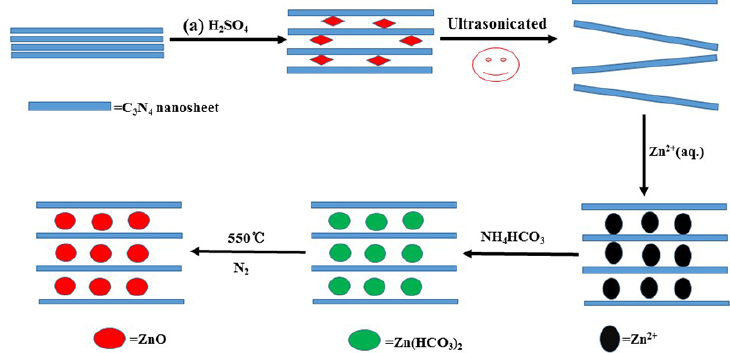
Figure 1. A schematic representation of the synthetic route to graphitic-C 3 N 4 (g-C 3 N 4 ) nanosheets (CN)/ZnO nanocomposites. CN: Graphitic-C 3 N 4 .